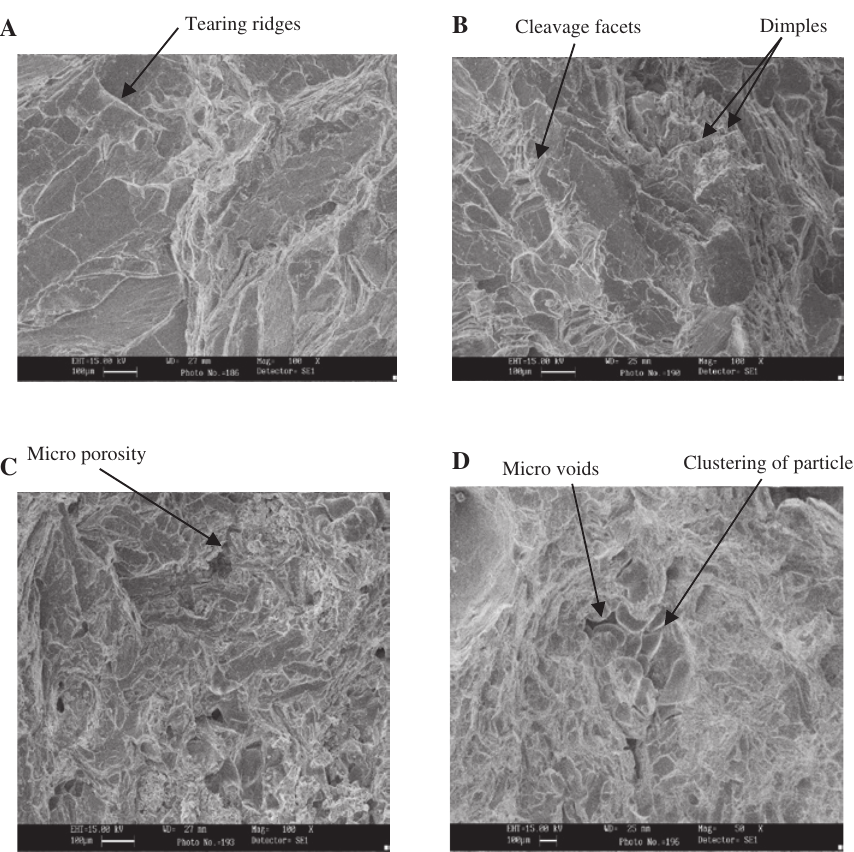
Figure 7: Scanning electron microscopy (SEM) fractograph of hybrid metal matrix composites (MMCs) of (A) 5%, (B) 10%, (C) 15%, and + SiC reinforcements in 7075 Al-alloy (D) 20% of the Al O 2 3